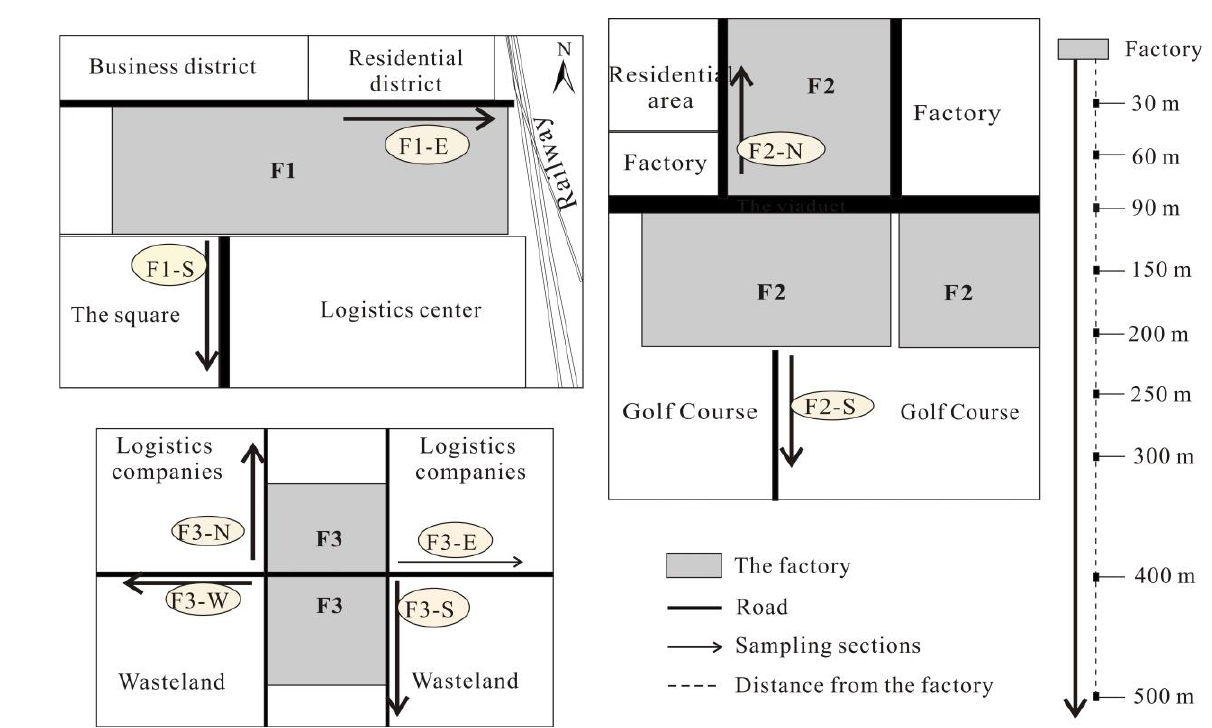
Figure 2. Distribution of the dust sampling sections.